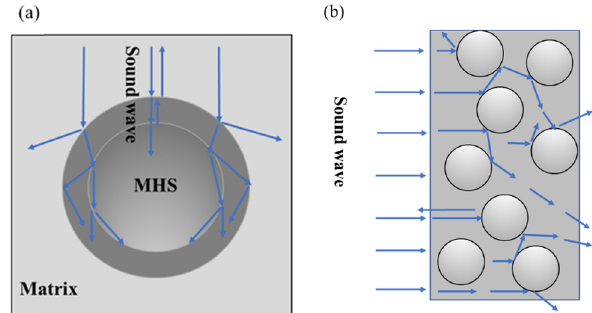
Figure 8: The schematic diagram of sound waves propagation mechanism in MHSCs under resonance condition: ( a ) at the MHS and ( b ) in the